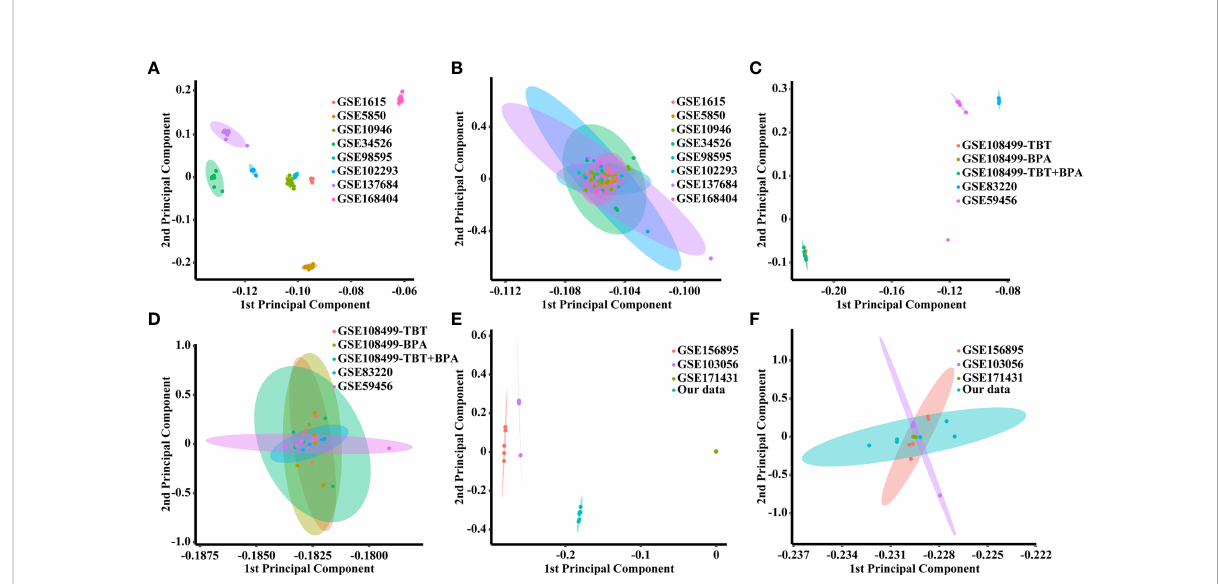
FIGURE 2 PCA score plots for classifying samples from different datasets. (A) Human datasets before batch effect removal. (B) Human datasets after batch effect removal by the EB method. (C) Rat datasets before batch effect removal. (D) Rat datasets after batch effect removal by the EB method. (E) Mouse datasets before batch effect removal. (F) Mouse datasets after batch effect removal by the EB